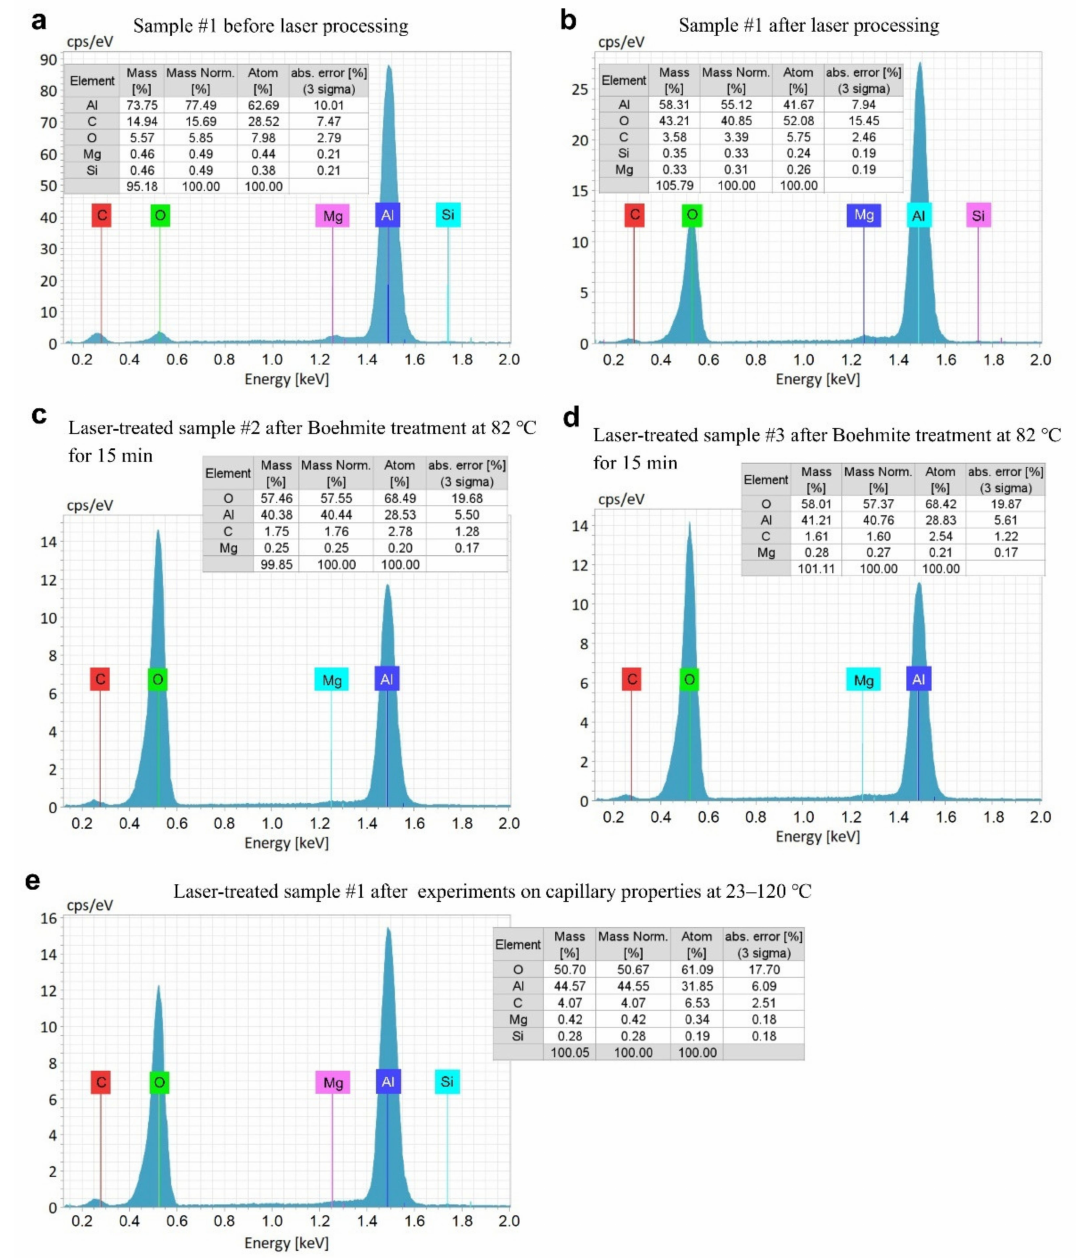
Figure 3. ( a ) Elemental composition of the sample #1 surface before laser processing. ( b ) Elemental composition of a sample surface after laser processing (sample #1). ( c ) Elemental composition of the sample surface after water treatment at 82 ◦ C for 15 min (sample #2). ( d ) Elemental composition of the sample surface after water treatment at 100 ◦ C for 15 min (sample #3). ( e ) Elemental composition of the sample #1 after water capillary flow experiments at 23–120 ◦